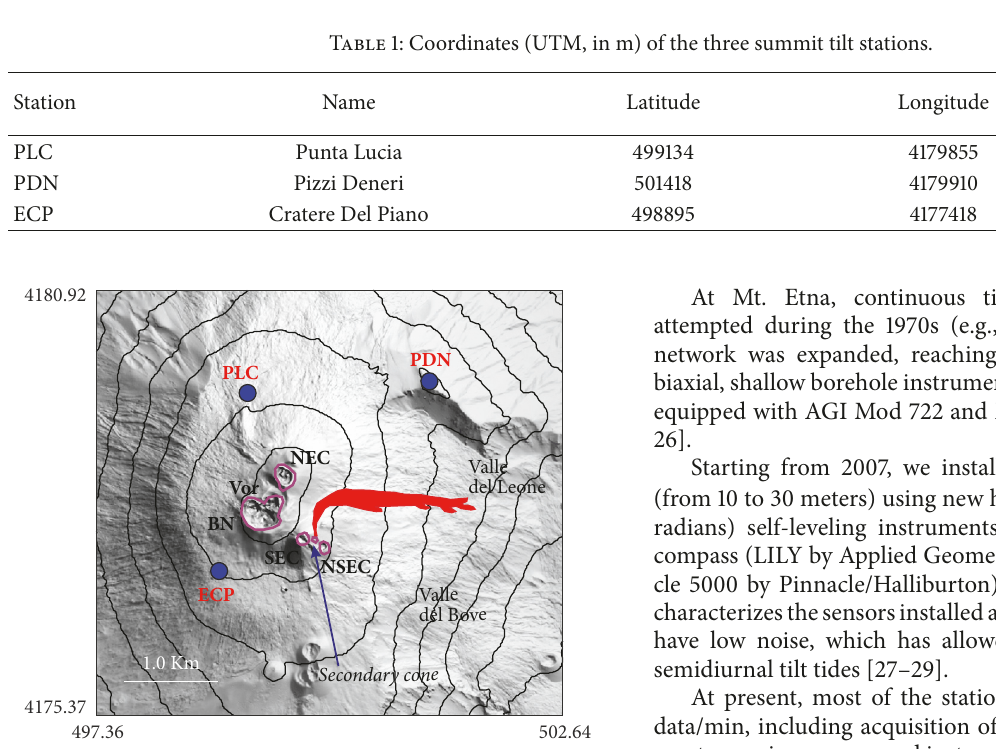
Figure 3: Map of the summit crater area showing the position of the 23-26 August eruptive fissure and lava flow. BN = Bocca Nuova; VOR = Voragine; NEC = Northeast Crater; SEC = Southeast Crater; NSEC = New Southeast